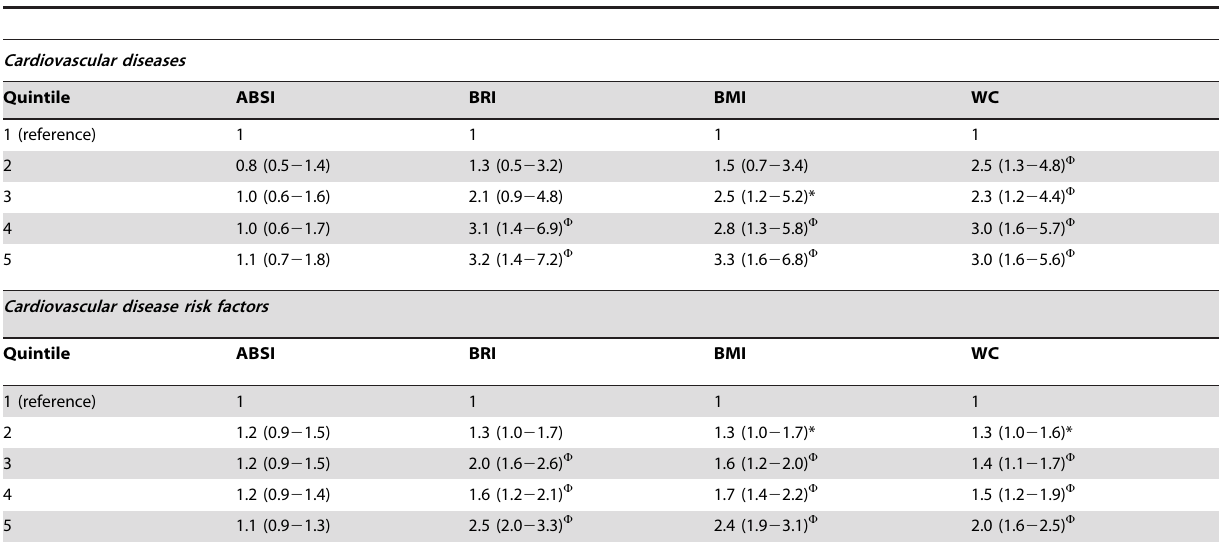
Table 5. The odds of CVD and CVD risk factor prevalence for quintiles of ABSI, BRI, BMI, and WC adjusted for sex, age, and smoking.